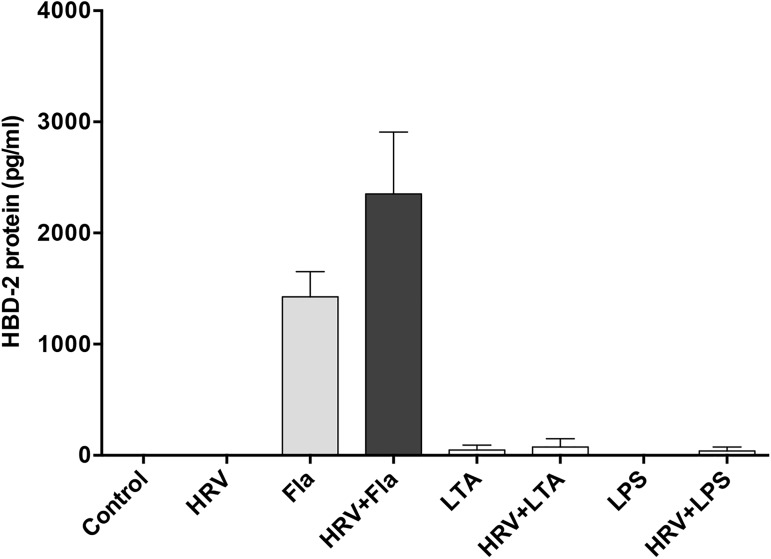
Flagellin (Fla), but not lipoteichoic acid (LTA) or lipopolysaccharide (LPS), induce HBD-2 production from human bronchial epithelial (HBE) cells.HBE cells were treated with medium control, HRV-16 (HRV), Fla (30 ng/mL), LTA (1 μg/mL) LPS (1 μg/mL), alone and in combination with HRV. HBD-2 protein was assessed after 48 h. Data are expressed as mean ±SEM (n = 5).